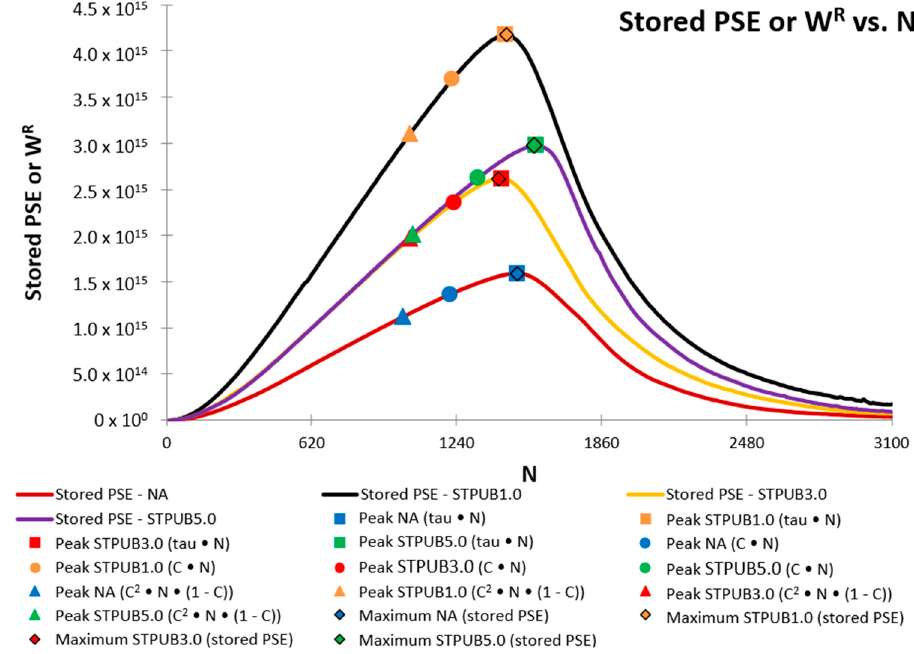
Figure 10. Failure de fi nition points identi fi ed on stored PSE (WR) curves.